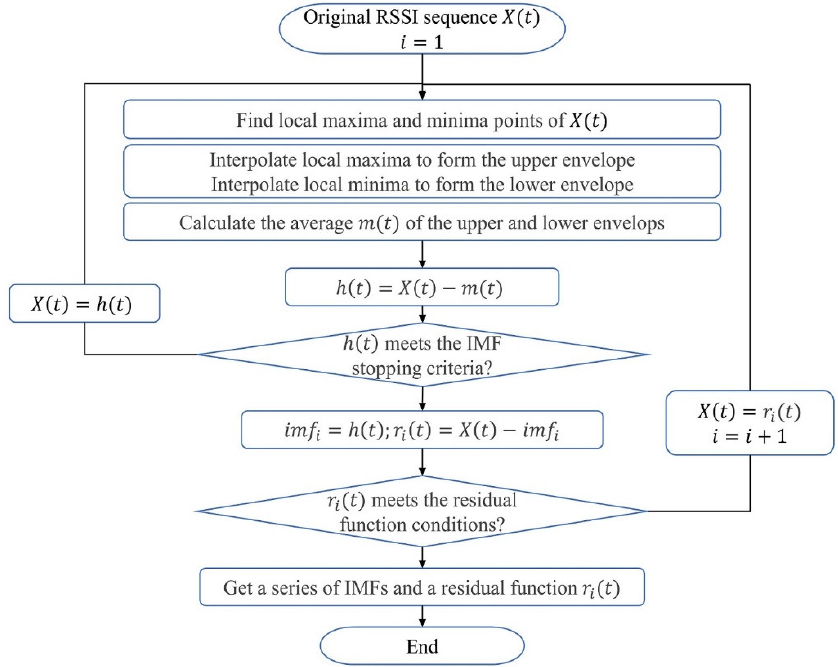
Figure 1. The flow chart of the EMD algorithm.